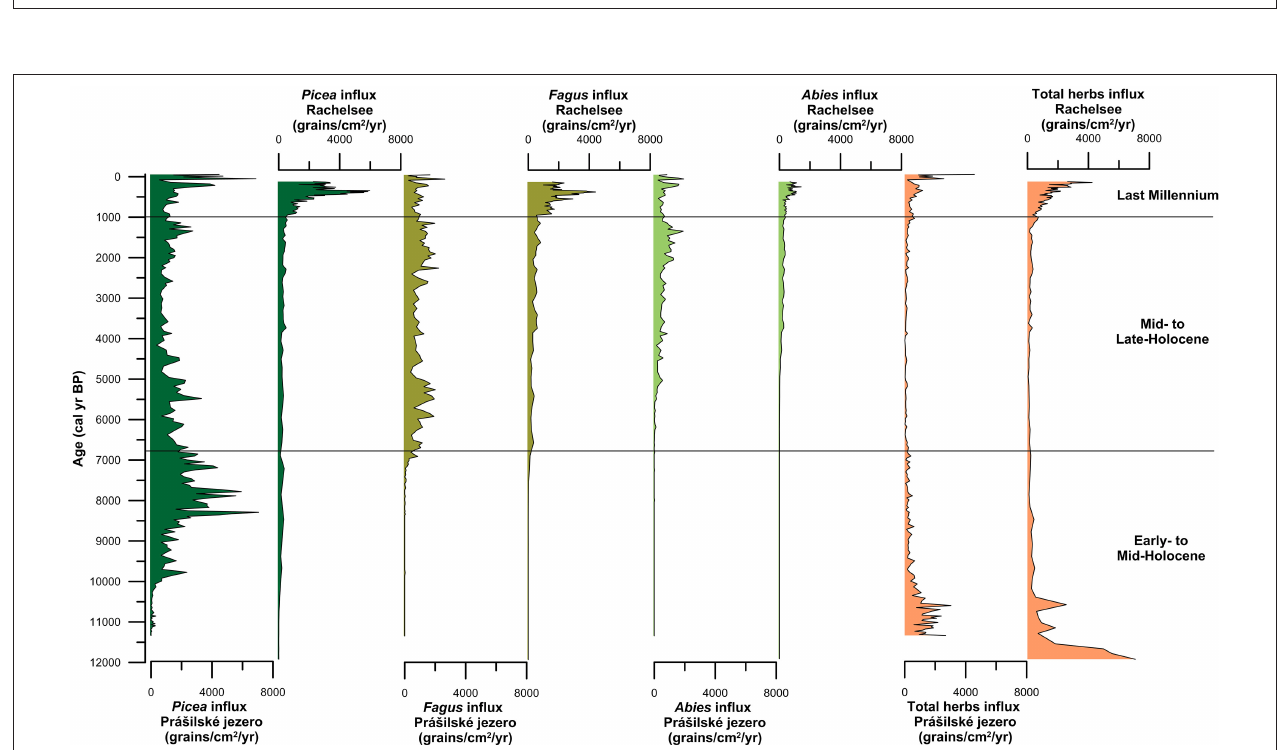
FIGURE 5 | Pollen influxes for the three dominant canopy species ( Picea, Fagus , and Abies ) and total herbs from Prášilské jezero and Rachelsee located in the Bohemian/Bavarian Forests of central Europe.